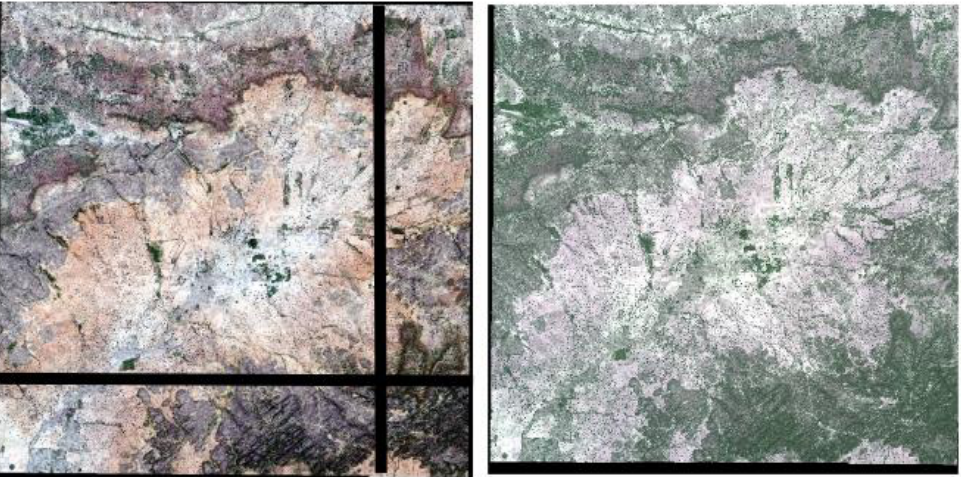
Figure 4. Raw data ( left ) and a stitched, radiometrically, and atmospherically corrected, orthorectified, co-registered, and tree/cloud masked image ( right ).